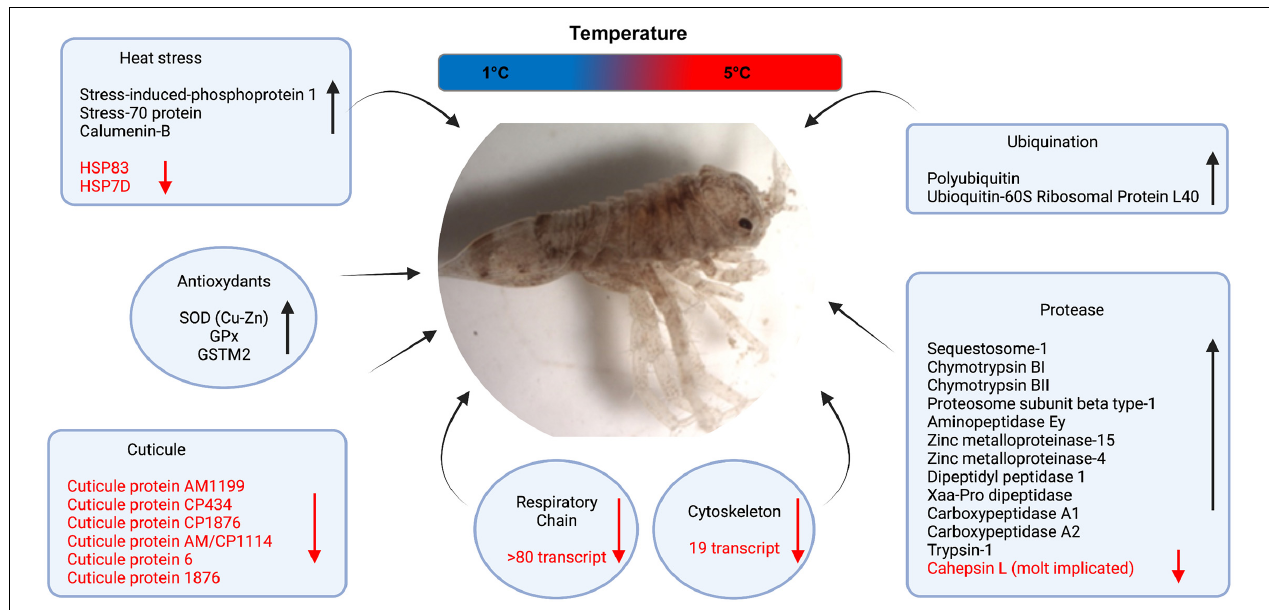
FIGURE 2 | Relevant molecular pathways with differentially expressed transcripts. Up-regulated transcripts are shown in black and down-regulated in